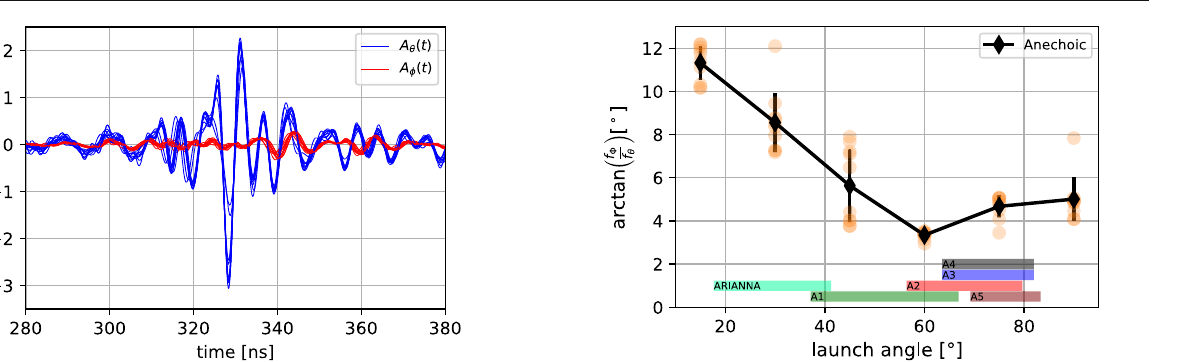
Fig. 7 Pulsesemittedatalaunchangleof30 ◦ fromtheanechoiccham- ber. θ traces are indicated in blue and φ traces are indicated in red